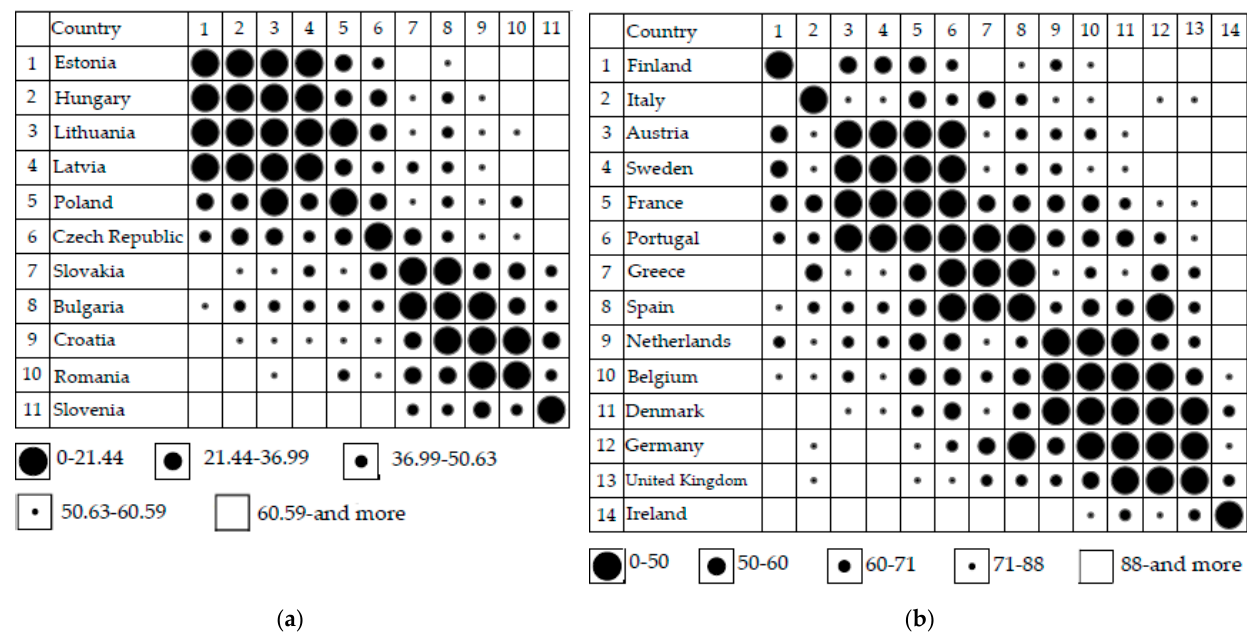
Figure 2. Similarity of EU Member States in terms of renewable energy production structure (by source) as of 2018: ( a ) Countries that joined the EU in 2004 or later, ( b ) Countries that joined the EU before 2004. Own study based on [49].